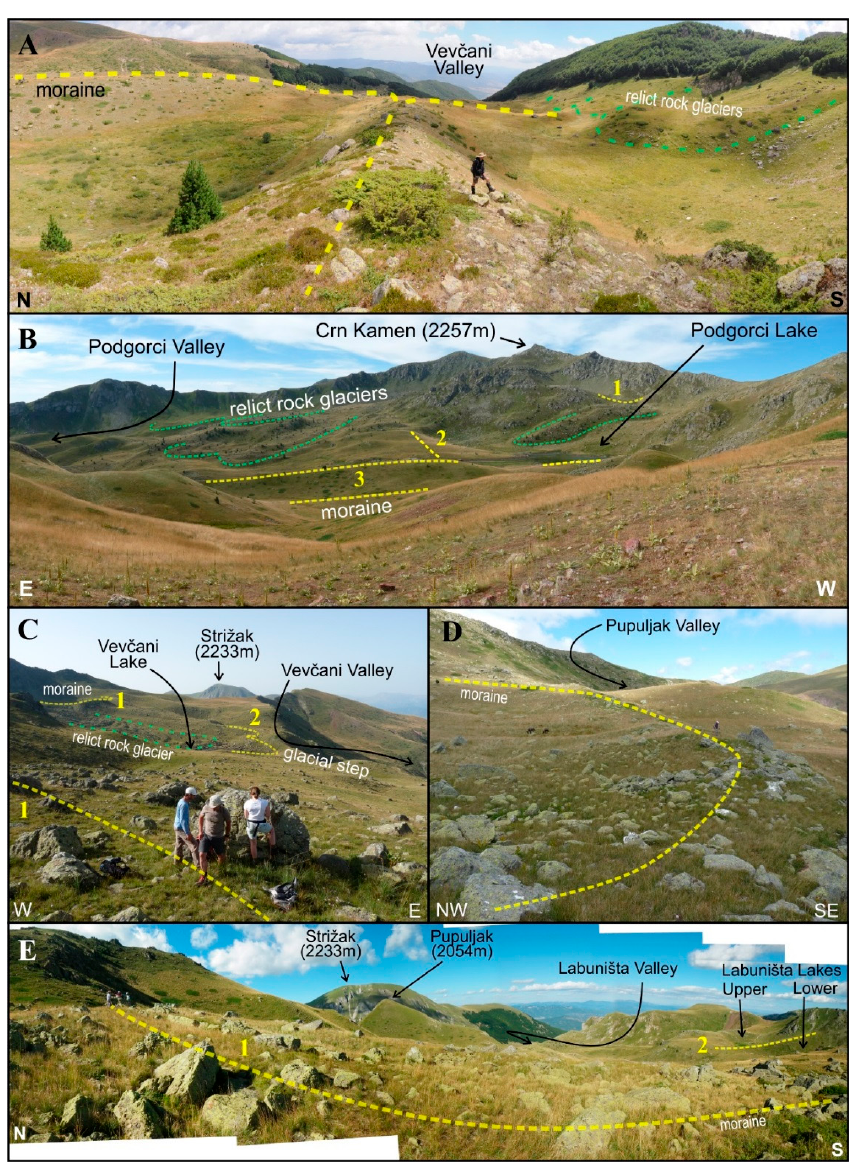
Figure 5. Characteristic glacial and periglacial features of the study area. ( A ) Moraines of Jurassic conglomerate (Golina Member) in the middle part of Vev č ani Valley at Golina locality; ( B ) Several moraine generations (yellow dashed lines, Lincura (1), Golina (2) and Leništa (3) Members) and rock glaciers (reworked glacial sediments; green dashed lines) in the Upper Podgorci Valley; ( C ) Moraines from Lincura (1) and Lokva (2) Members and rock glaciers in the Upper Vev č ani Valley; ( D ) Moraine of the smallest glacier (Lincura Member) in the Upper Pupuljak Valley; ( E ) Moraine of the Lincura Member in the Upper Labuništa Valley (1) and Lateral moraine belonging to the Golina Member in the Upper Podgorci Valley (2). For location of the photos refer to Figure 3.